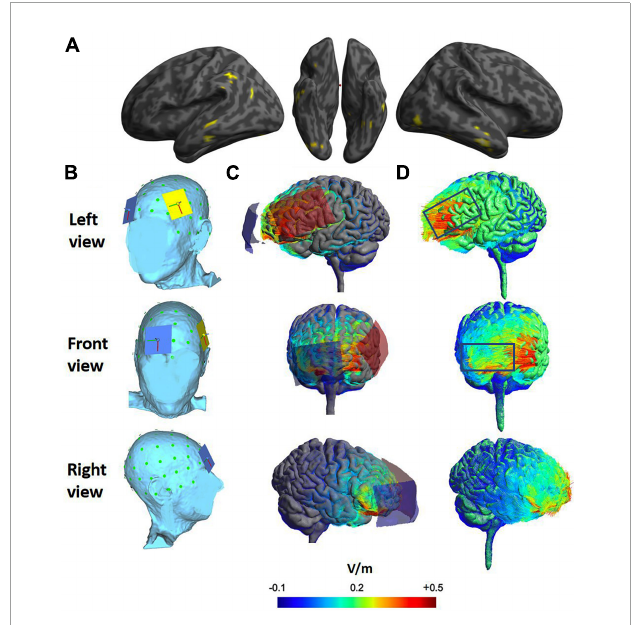
FIGURE1 (A) Voxel-based morphometry showing regions of significant gray matter volume loss in yellow (thresholded voxel-wise at p < 0.001; corrected for family wise error at cluster level p < 0.05). (B) Position of anode (yellow over F5) and reference electrode (blue over Fp2). (C) Modeling of electrical fields induced by tDCS using SimNIBS. Current flow from anode (red) to cathode (blue) with 5 cm × 7 cm electrode/sponge shape depicted. (D) Magnitude of the induced electrical field. The directional fields normal to the cortical surface. The positive values (red lines) indicate inward field entering the cortical surface and negative values (blue lines) indicate outward electrical field leaving the